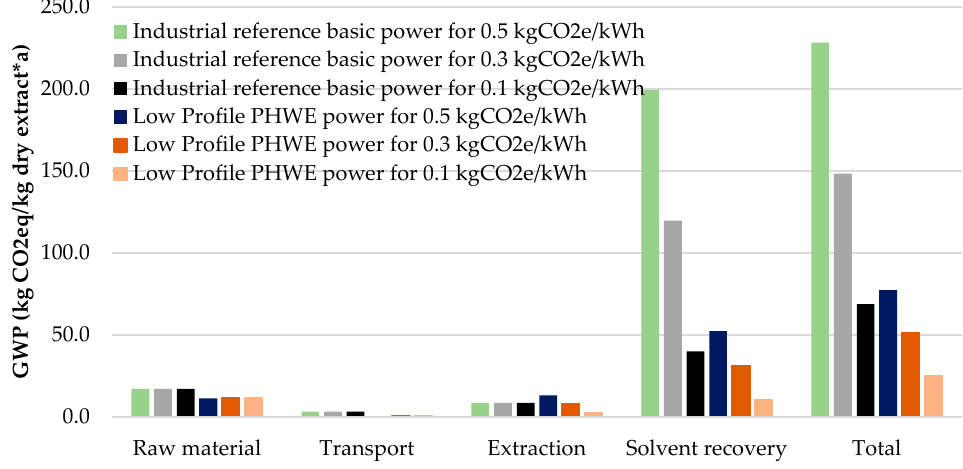
Figure 13. Dependence of extraction processes on indirect CO 2 emissions from power generation. Pressurized hot water extraction (PHWE).